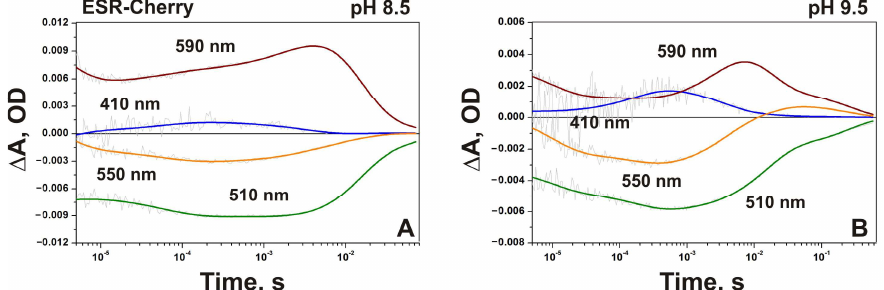
Figure 4. Light-induced absorption changes at four characteristic wavelengths (410 nm, 590 nm, 550 nm, and 510 nm) at pH 8.5 ( A ) and 9.5 ( B ) in proteoliposome suspensions containing